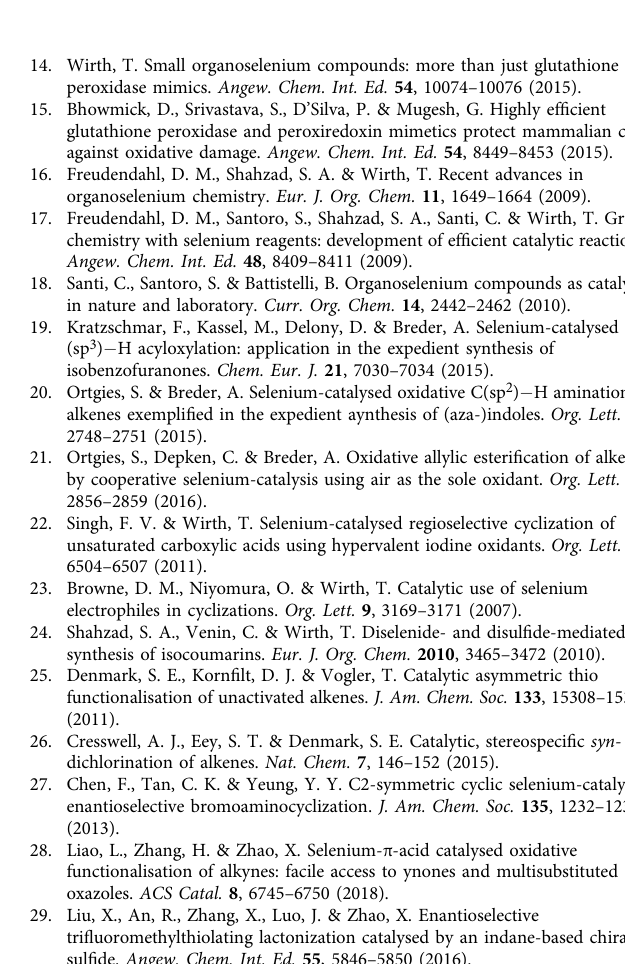
Fig. 4 Application of the Se-catalysed reaction in aqueous conditions. a Conditions: 1v (0.1 mmol), PhSeBr (10 mol%), DMSO/PBS buffer = 1:19 (4.0 mL); at ambient temperature for 8 h; the yield was isolated yield. b Fluorescence spectra of reaction in aqueous conditions, λ ex = 380 nm. c Visual fl uorescence of the reaction mixture under a 365 nm ultraviolet